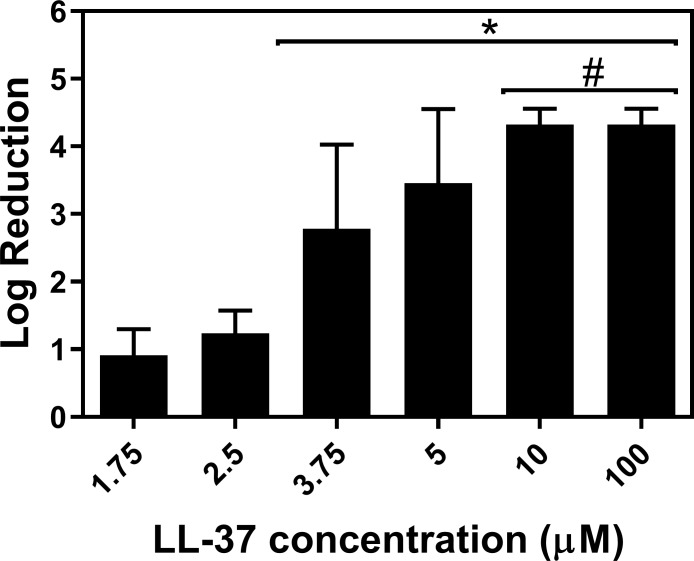
Dose-response effect of LL-37 against S. aureus biofilms.The antimicrobial peptide, LL-37, was used to treat 24 h S. aureus biofilms for 60 min. LL-37 was found to present high antimicrobial activity against S. aureus biofilms, with a more than 4 log reduction at concentrations starting at 10 μM. * Statistically significant from 1.75 and 2.5 μM; # statistically significant from 3.75 and 5 μM.